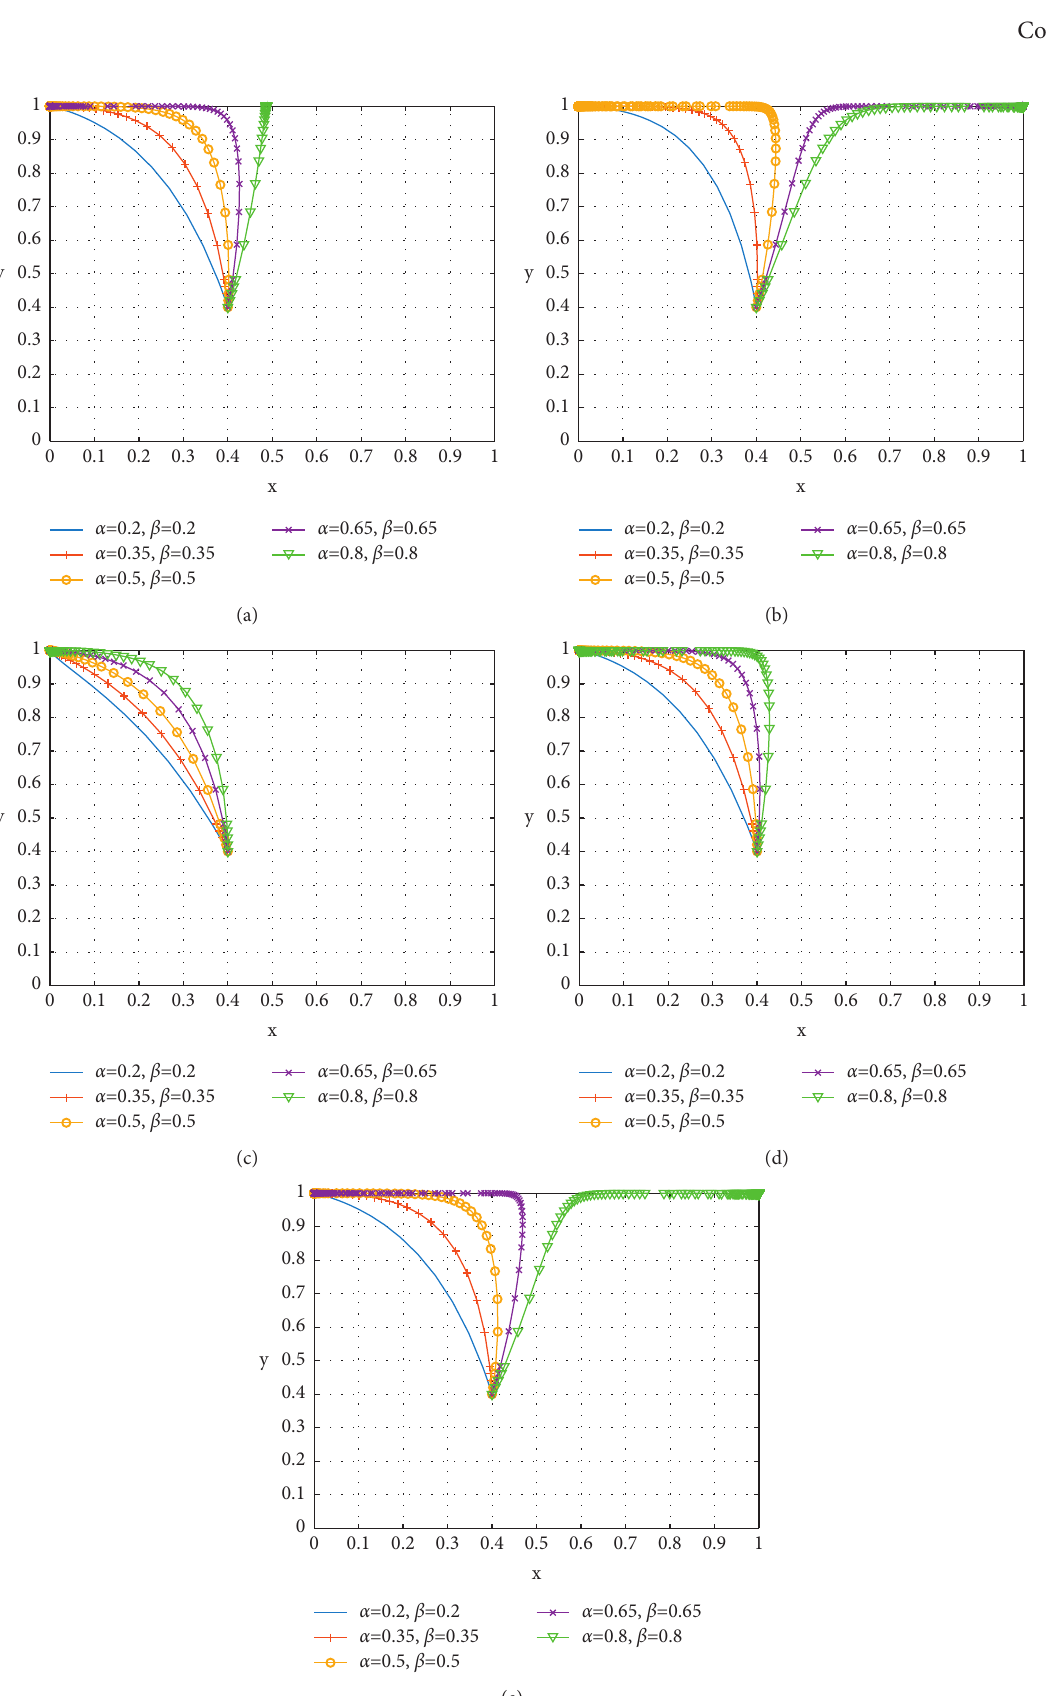
� 0 ,A � 0. (b) A � − 1 ,A � − 1. p s p s